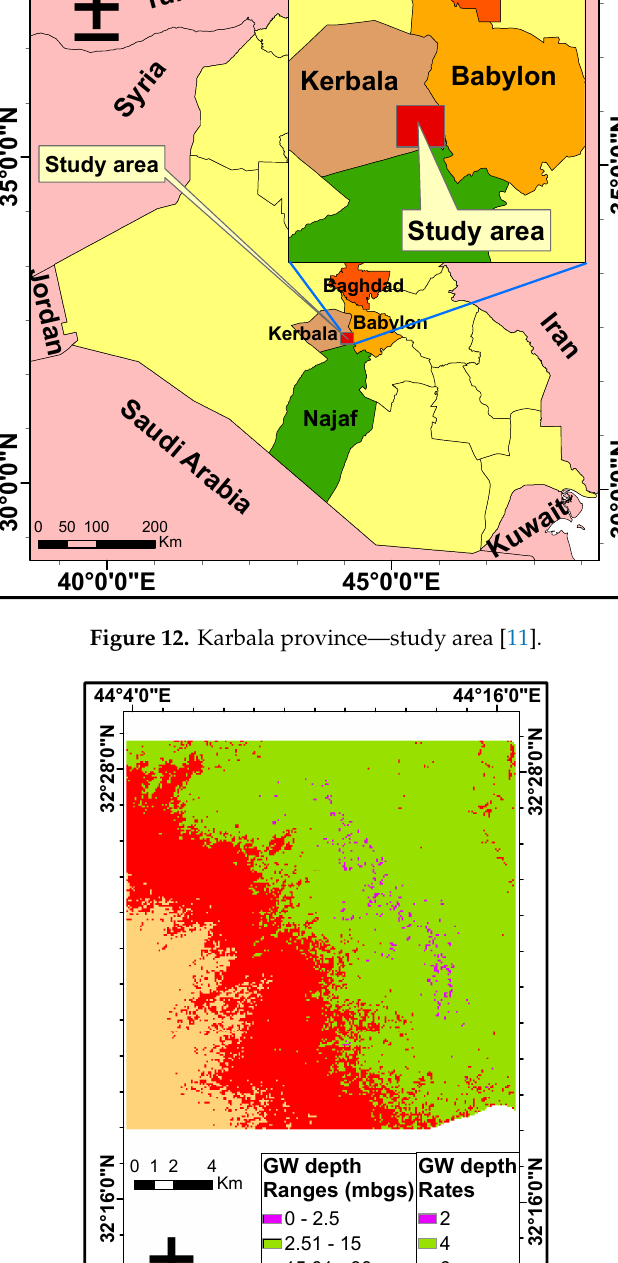
Figure 14. Site selection map for Karbala province—study area [11]. According to the findings from this study, the suggested method can be used to decrease the electricity demand of the city through installing an aquifer thermal energy storage system. It can be used to find the best location that guarantees the maximum storage efficiency according to the in-site